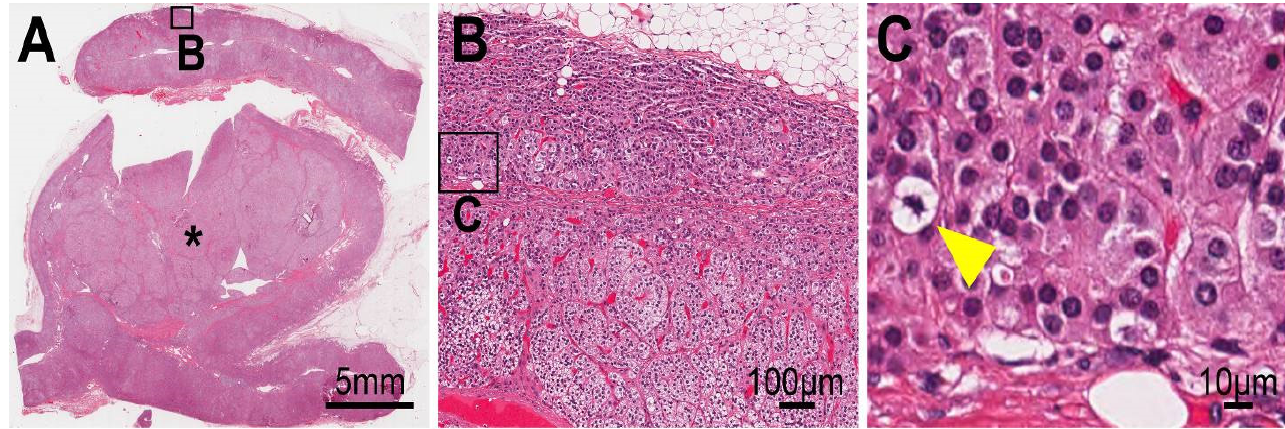
Figure 2. Adrenal histology of the case. The non-tumor adrenal portions were hyperplastic (panels ( A ) and ( B )) and harbored mitotic cells (yellow arrowhead in panel ( C )). *: the larger tumor (* in Figure 1).